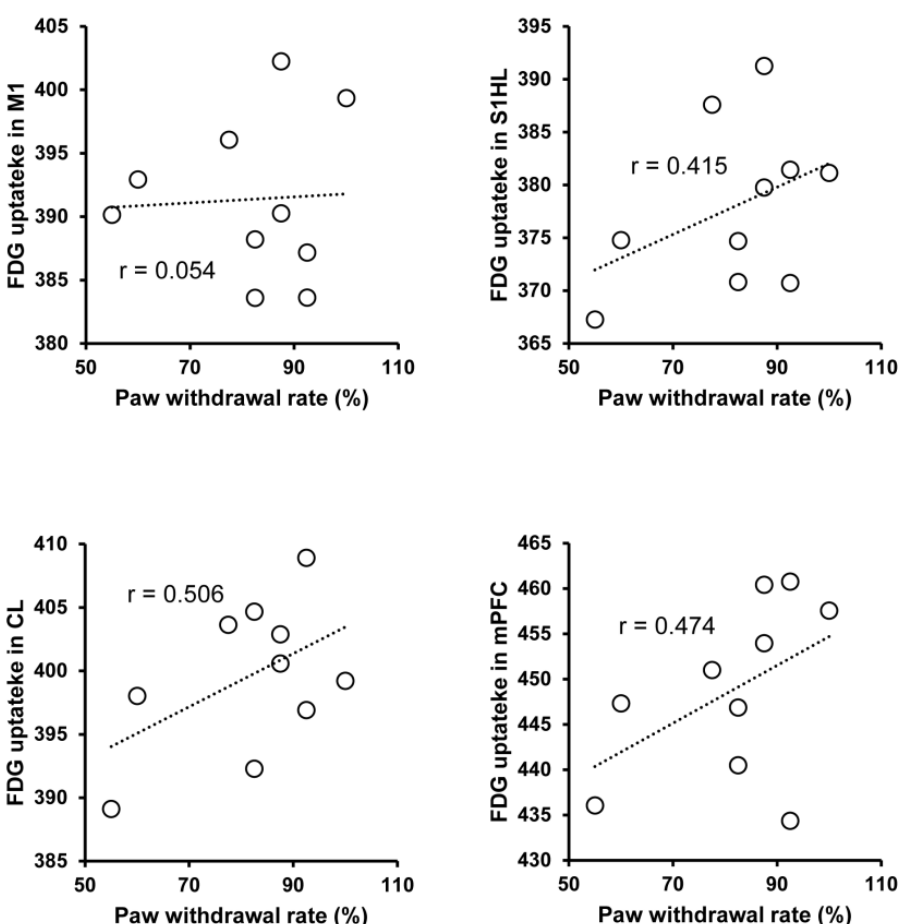
Figure 4. Correlation between mechanical allodynia-related behavioral changes and regional brain activity in neuropathic pain rats. The mean value of FDG uptake in the M1, S1HL CL, and mPFC were plotted against mechanical allodynia-related behavioral changes in SNL rats ( n = 10). The Pearson coefficient value (r) is shown for each relation. Abbreviations: M1, primary motor cortex; S1HL, primary somatosensory cortex, hindlimb region; CL, centrolateral thalamic nucleus; mPFC, medial prefrontal cortex.